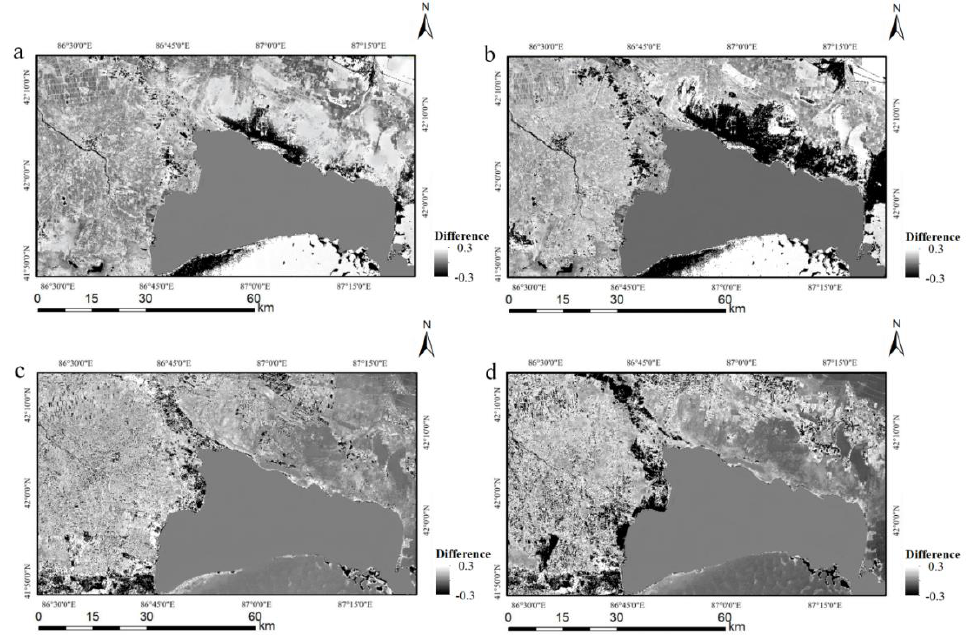
Figure 10. The difference map of the predicted NDVI and real GF-1 WFV NDVI at the same period. ( a , b ) were obtained by Expt.1 and Expt.2 on 10 July, respectively, and ( c , d ) were obtained by Expt.1 and Expt.2 on 21 August, respectively.